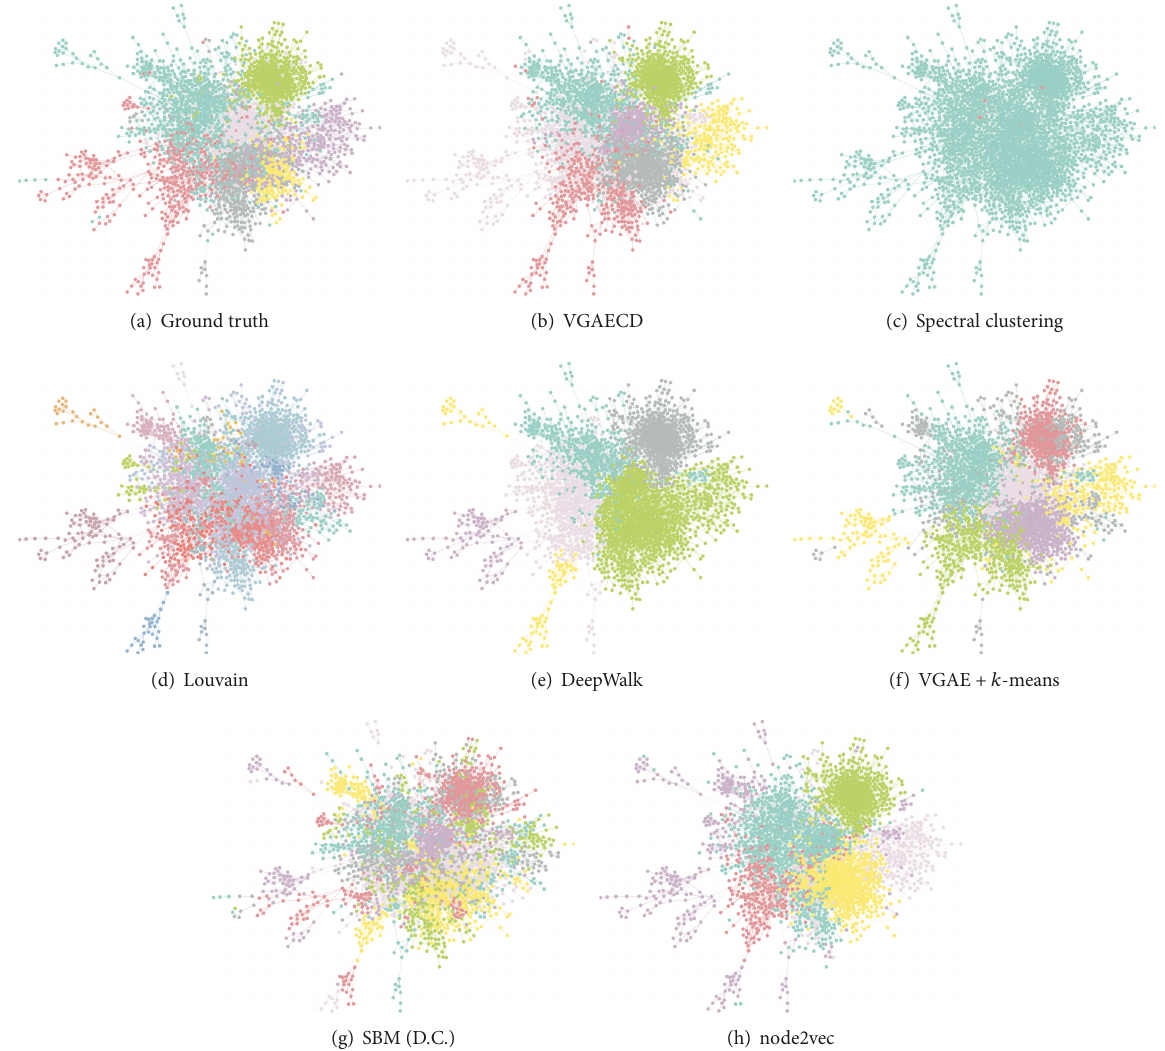
Figure 4: Visualization of community assignment on Cora Dataset (largest connected